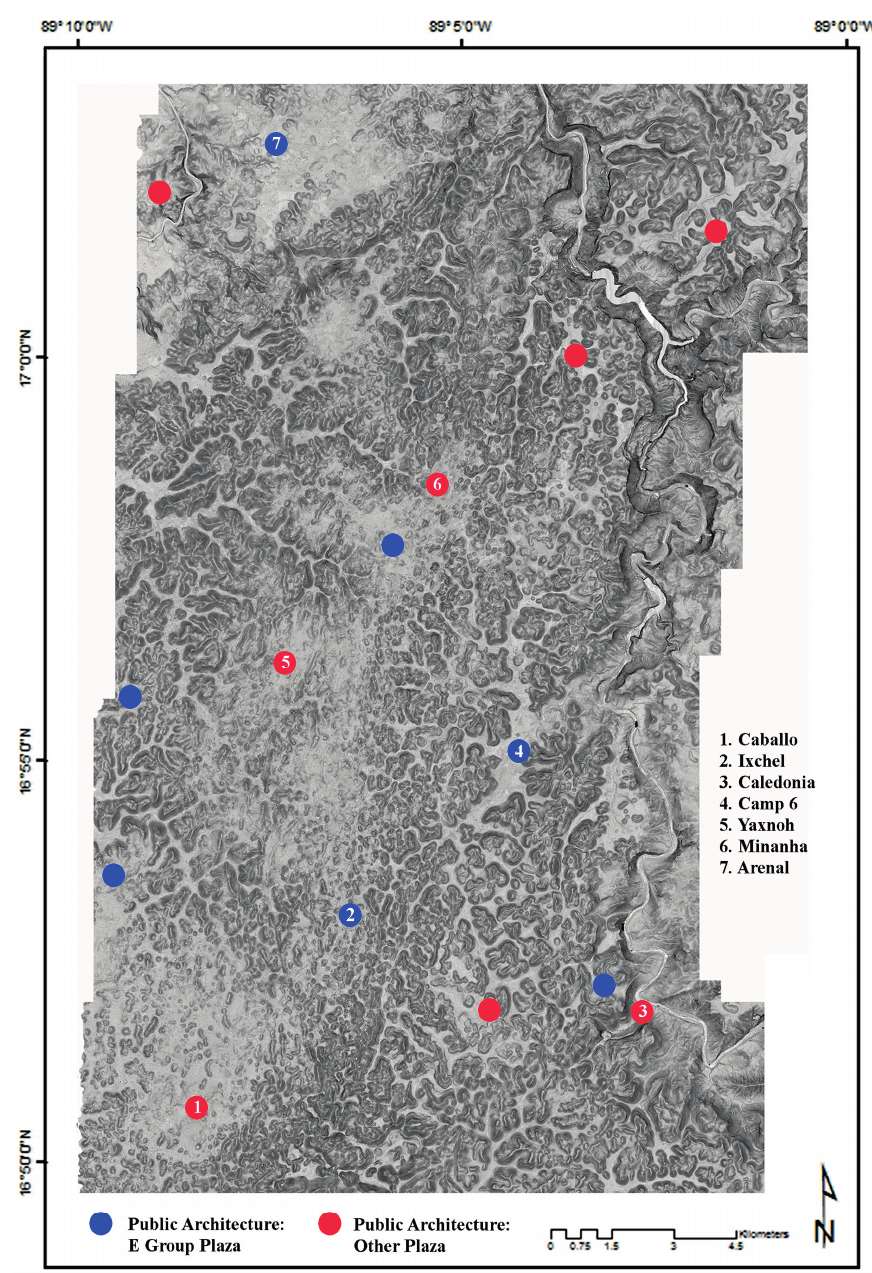
Figure 5. The 2013 LiDAR DEM of the central survey area showing the distribution of sites with public architecture (Macal River to the east; Guatemala border to the west). Architectural complexes mentioned by name in the text are